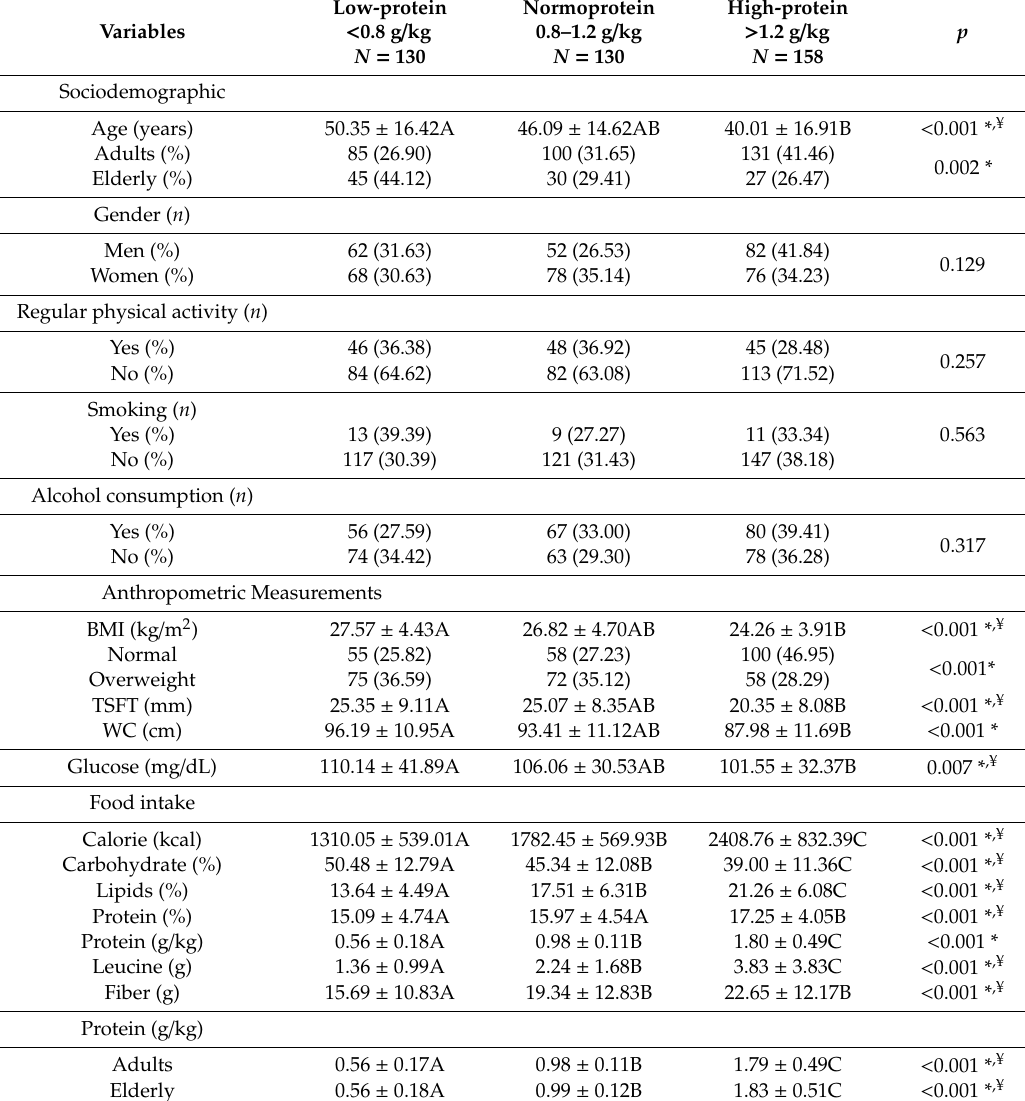
Table 1. Demographic profile anthropometric measurements, blood glucose concentrations, food intake of volunteers according to protein